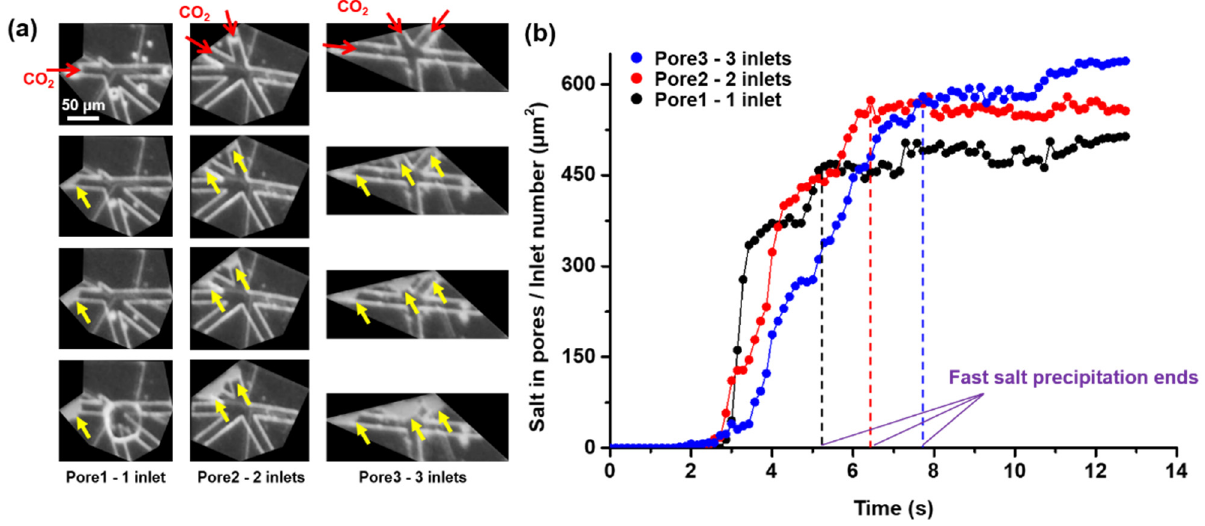
Figure 5. Salt precipitation and accumulation in the 5- µ m deep pores. ( a ) Recorded salt precipitation and accumulation results in three individual pores with 1–3 inlets. ( b ) Salt particle accumulation dynamics in three pores.